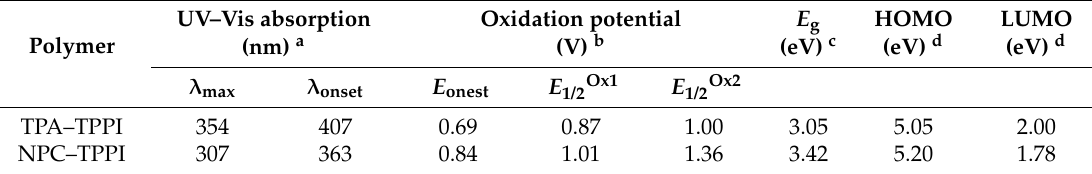
Table 1. Optical and electrochemical properties of the electro-synthesized polymers.